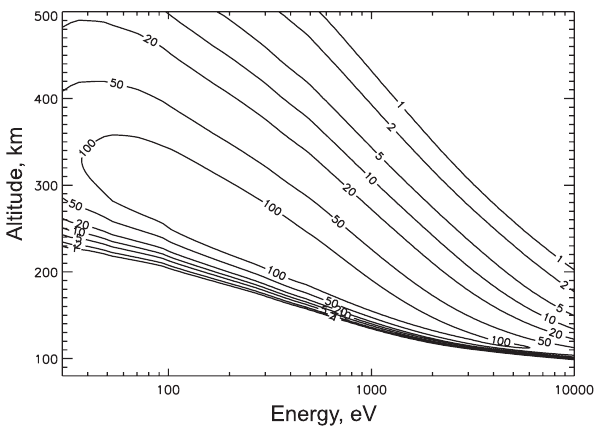
Fig. 2. HiTIES spectrograph plot showing the intensities of auroral emission lines as a function of wavelength. Data from four consec- utive 30s integrations are shown by (in order) the black, blue, green and red lines. The response of the filter used on the Andor imager is shown by the black dashed